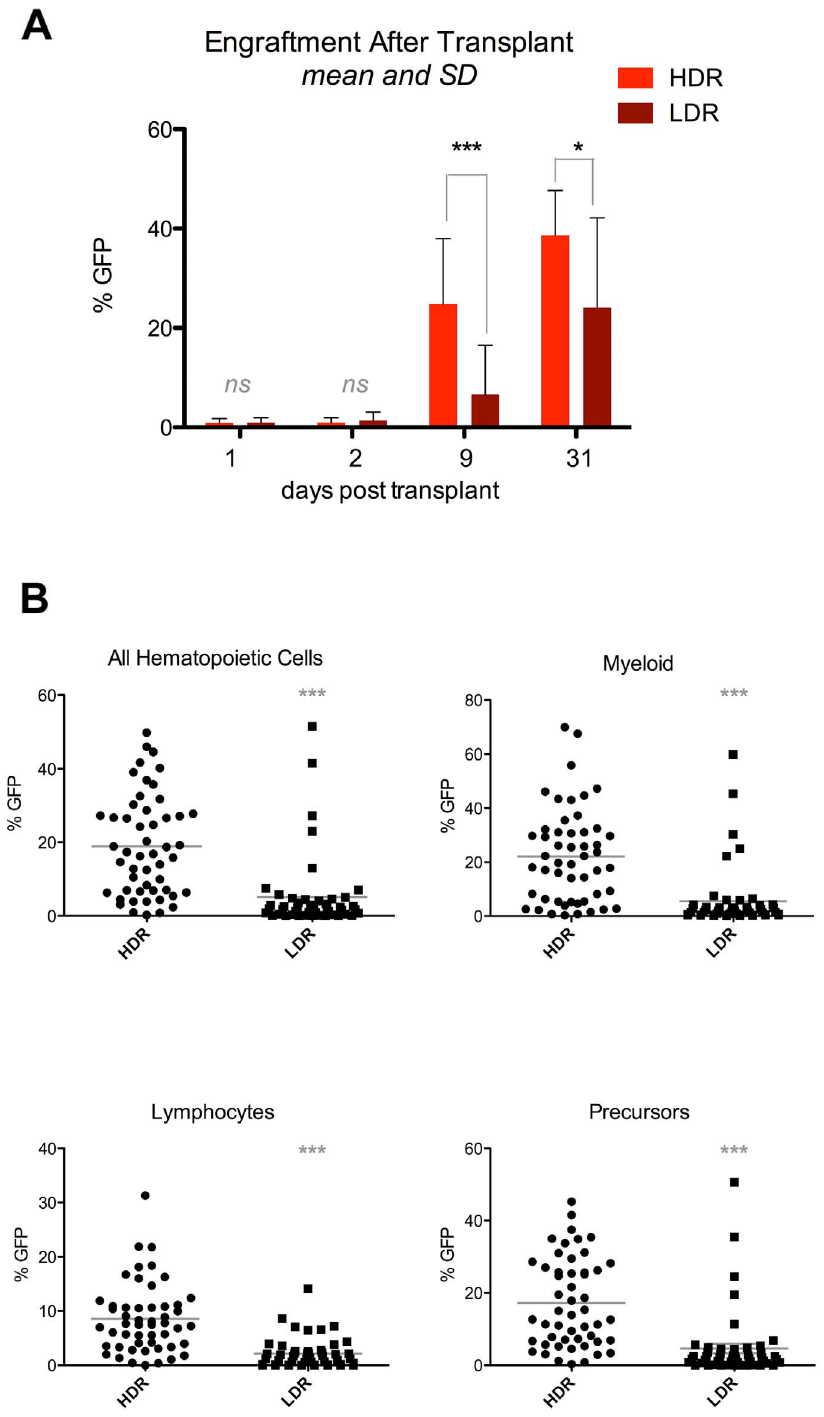
Figure 4. Hematopoietic cell transplant after radiation. A, WT zebrafish were irradiated with 20Gy at either 800 cGy/min (HDR) or 25 cGy/min (LDR), and transplanted with bactin2:EGFP hematopoietic cells. At 1, 2, 9, and 31 days after transplant, kidneys were harvested from recipients and isolated hematopoietic cells were analyzed by flow cytometry for percentages of GFP-positive cells. Data shows results from at least two independent biological experiments per timepoint, for totals of: 14 fish per group (1 dpt), 12–13 fish per group (2 dpt), 25–26 fish per group (9dpt), and 10–13 fish per group (day 31). 9 dpt p , 0.0001, 31 dpt p=0.0301. Bars show mean and SD. B, Flow cytometry analysis of hematopoietic cells isolated from transplanted fish 9 days after transplant. Each data point indicates results from one fish. Data is pooled from six biologically independent experiments; three with bactin2:EGFP donor cells and three with h2afv:EGFP donor cells, for cumulative totals of 51 and 48 fish in the HDR and LDR groups, respectively. p , 0.0001. Bars show the mean.